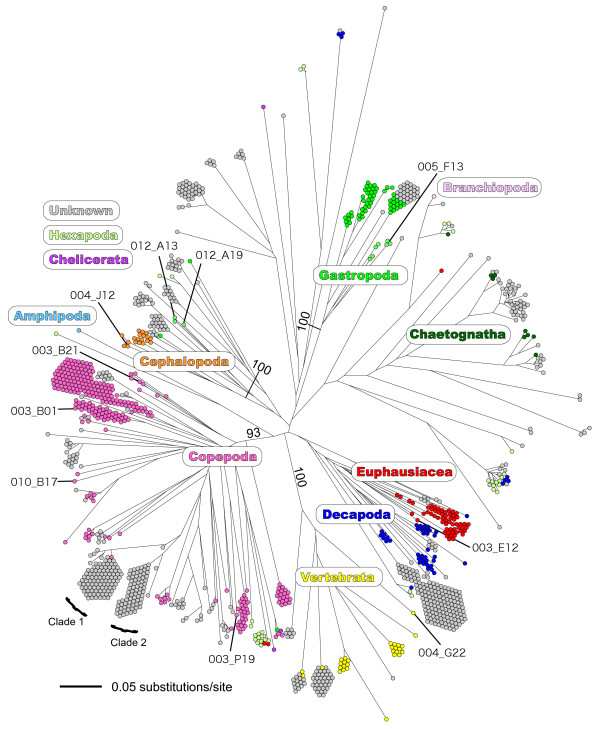
Unrooted neighbour-joining tree of the 1,336 mitochondrial COI gene sequence. Numbers beside internal branches indicate bootstrap values (>90%) obtained for 1,000 replicates (indicated for major branches only). Each dot represents a single mitochondrial COI gene sequence. Colour of each dot represent the higher taxonomic groups denoted in the figure with the criterion of the score and similarity more than 100 and 83%, respectively, in the BLAST results.